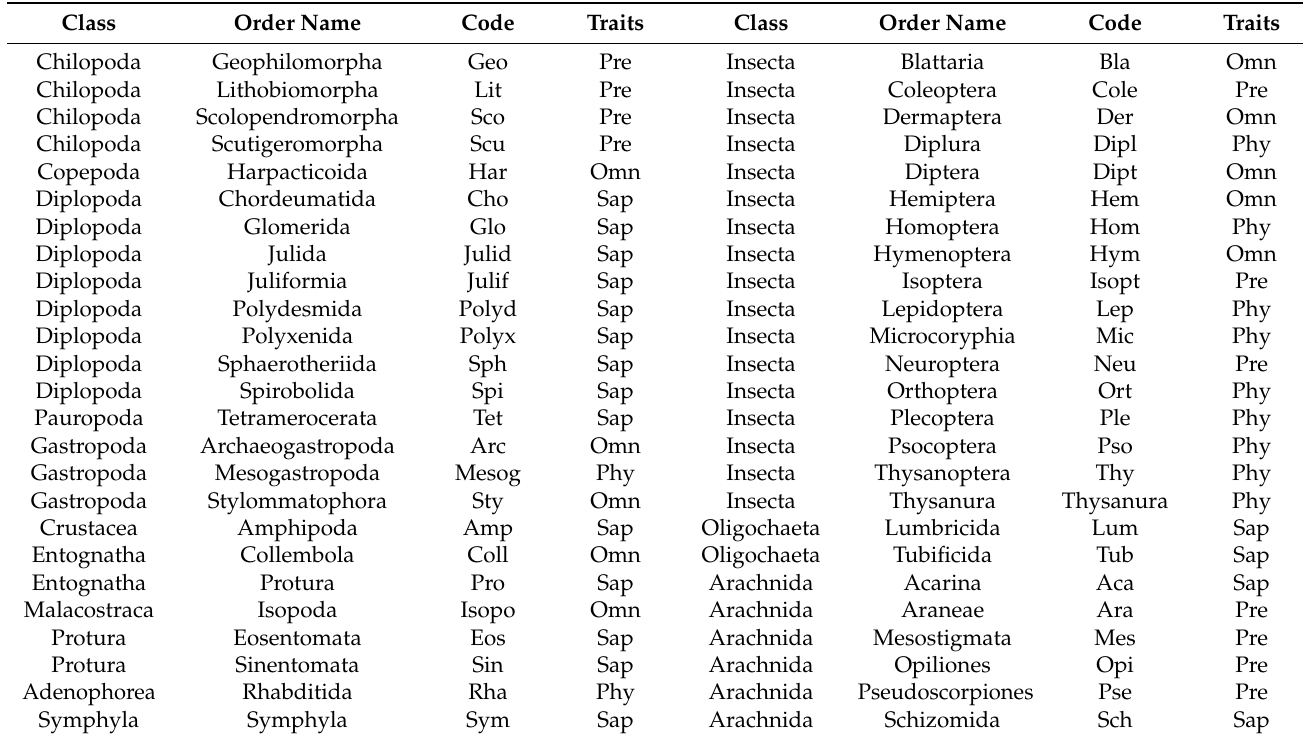
Table 3. List of soil fauna orders in the 14 sites in East Asia; Sap, Omn, Phy and Pre represent saprozoic, omnivores, phytophagous and predatory, respectively.